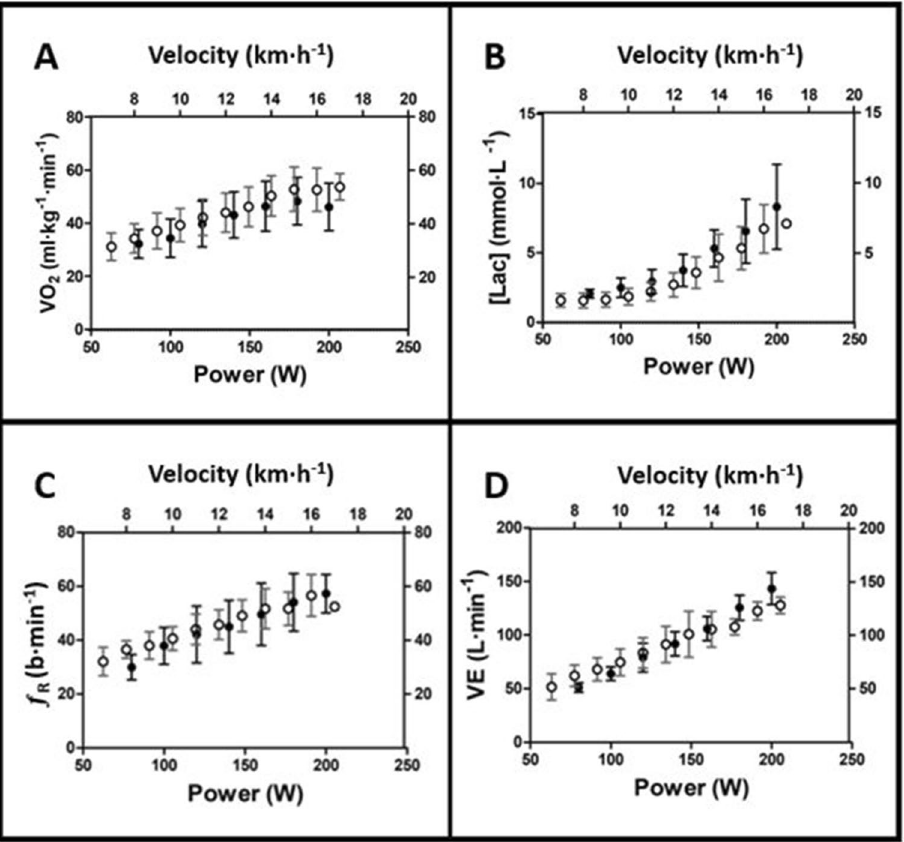
˙ V Figure 3. Descriptive data for O 2 ( A ), blood lactate concentration ( B ), ƒ R ( C ), and intensity test performed on NMT (filled circles) and MT (open circles). Power data in NMT is expressed considering only the horizontal orientation, to maintain the same intensity for each subject (see “Methods” section for